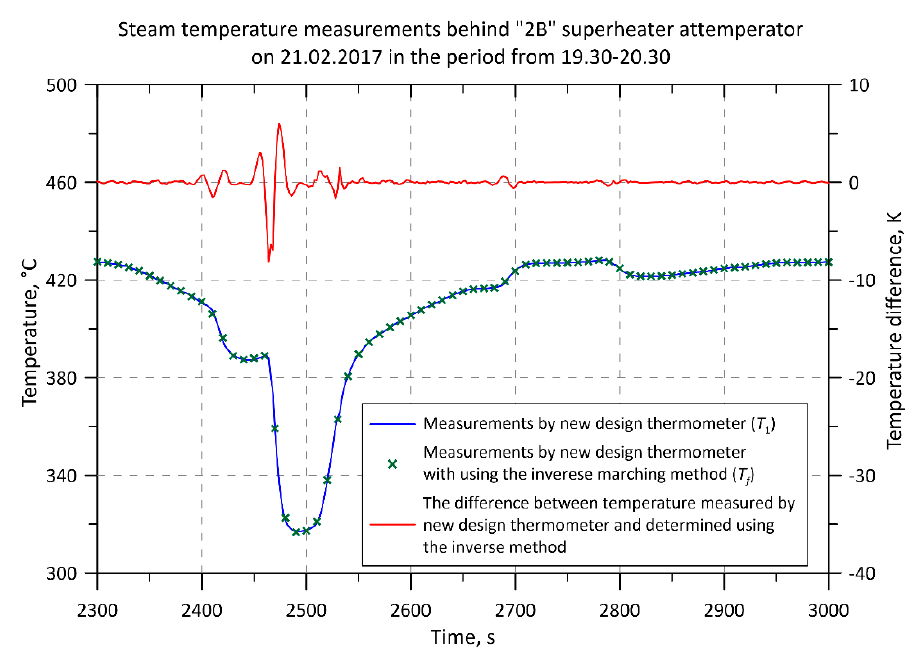
Figure 9. Comparison of superheated steam temperature downstream of the second superheater attemperator measured on side “B” side in the K11 boiler by new design thermometers and determined using the inverse method (selected fragment).